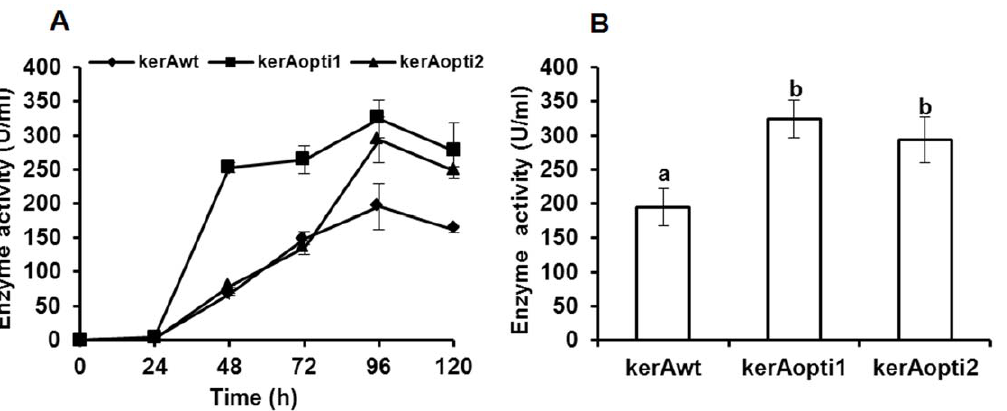
Figure 5. Recombinant keratinases production by P.pastoris X-33. A: Kinetics of keratinase production by P. pastoris pPICZ a -kerAwt, pPICZ a - kerAopti1 and pPICZ a -kerAopti2. B: Comparative expression of kerAwt , kerAopti1 and kerAopti2 in P. pastoris at 96 h. The values represent means 6 standard deviations (SD) of six independent positive transformants. Every transformant was examined in four independent experiments in quadruplicate. a,b Mean values were significantly different (P , 0.05) when labeled with unlike letters.